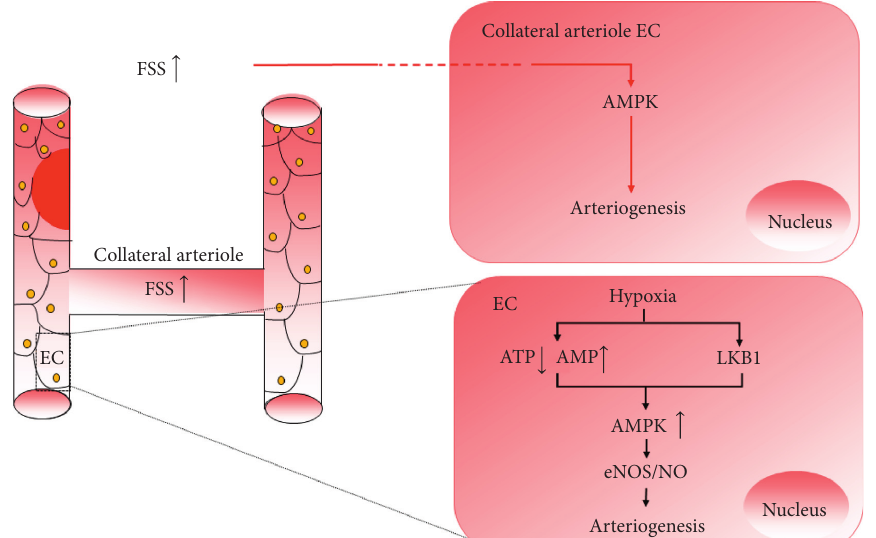
Figure 2: The roles of AMPK in revascularization. After vessels are occluded, remote tissues suffer ischemia and hypoxia, the blood perfusion of collateral arterioles increases, and the FSS is elevated. FSS and hypoxia activate AMPK by different or the same sprint cycling promotes phosphorylation of human skeletal muscle AMPK α Thr172 [133] (Figure 2).